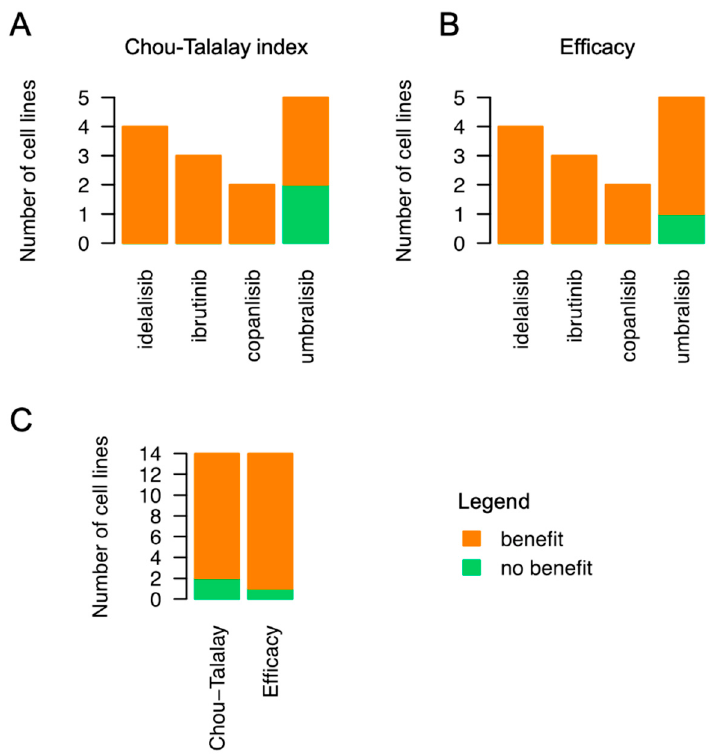
Figure 5. Combination of IRAK4 inhibitor emavusertib and BCR-signaling targeting agents is beneficial (synergistic or additive) in 12/14 models tested. Summary plots of all combinations tested in MZL parental and resistant lines. Cells were exposed (72 h) to increasing doses of idelalisib, ibrutinib, copanlisib or umbralisib alone or in combination with increasing doses of emavusertib followed by MTT assay. Synergy scores from Chou-Talalay ( A ) and MuSyc (Efficacy, B ) models identified beneficial effects on the addition of emavusertib to inhibitors of downstream BCR signaling.